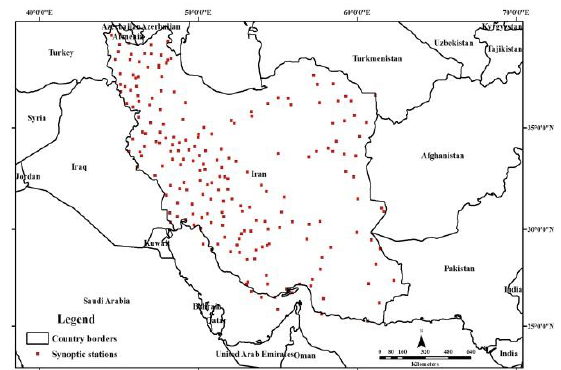
Figure 2. Distribution of 212 synoptic stations utilized in this